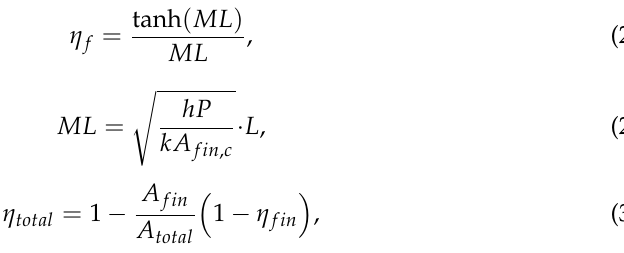
Table 5. Variables of the experiment.